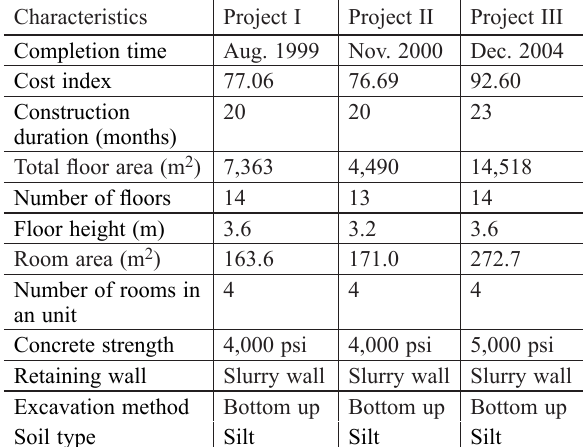
Table 4. General descriptions of three case